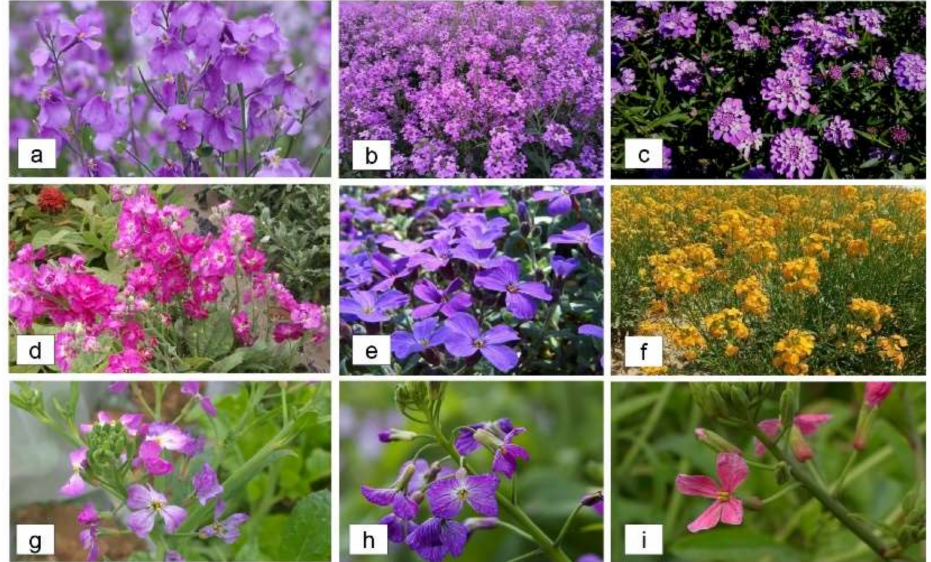
Figure 6. Ornamental Cruciferae species. ( a ) Orychophragmus violaceus ; ( b ) Hesperis matronalis ;